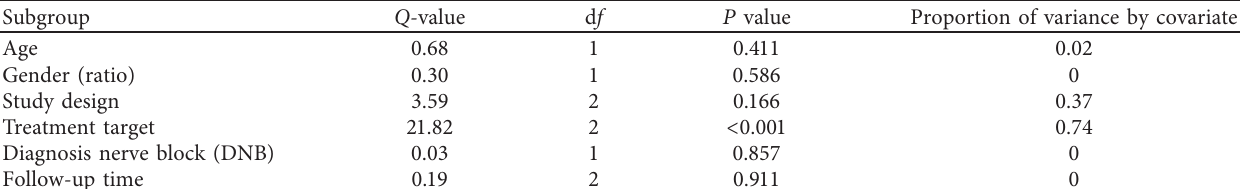
Table 6: The sources of between-study heterogeneity on pain intensity by metaregression analysis.